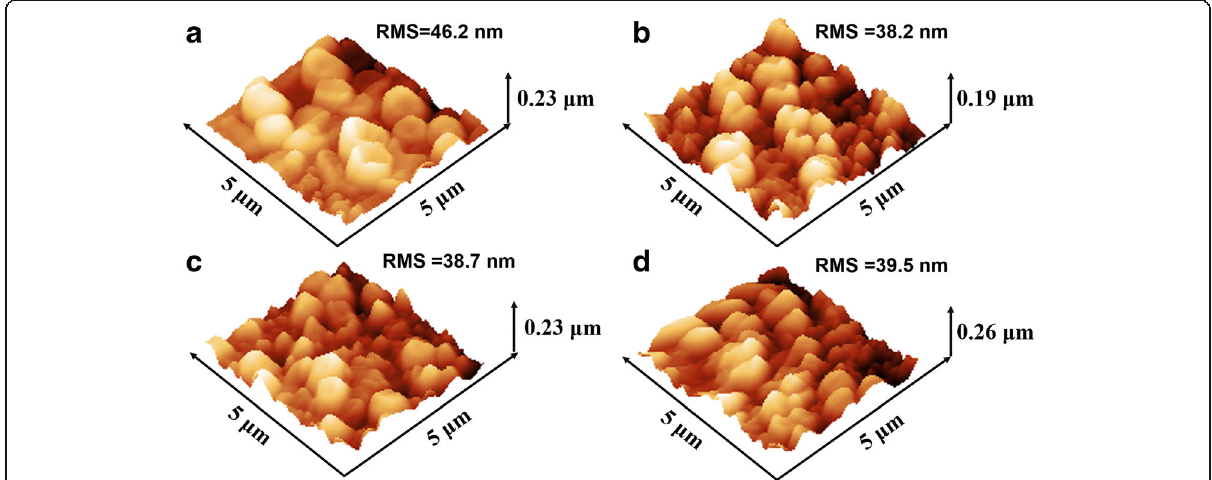
Fig. 5 AFM morphology images of MAPbBr 3 films: a based on pristine PEDOT:PSS film and b – d based on PEDOE:PSS films treated with MeOH, EtOH, and IPA, respectively